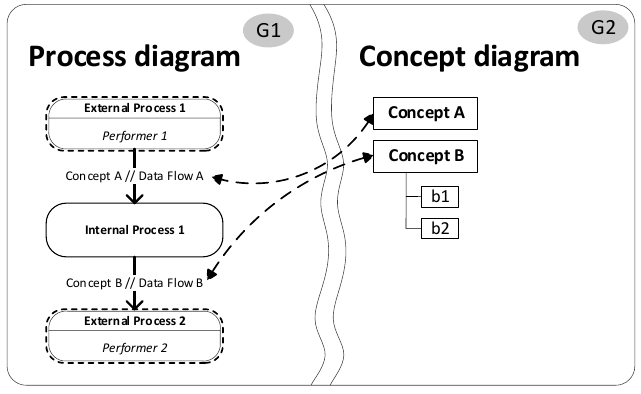
Fig. 1. Notation of the Two-Hemisphere